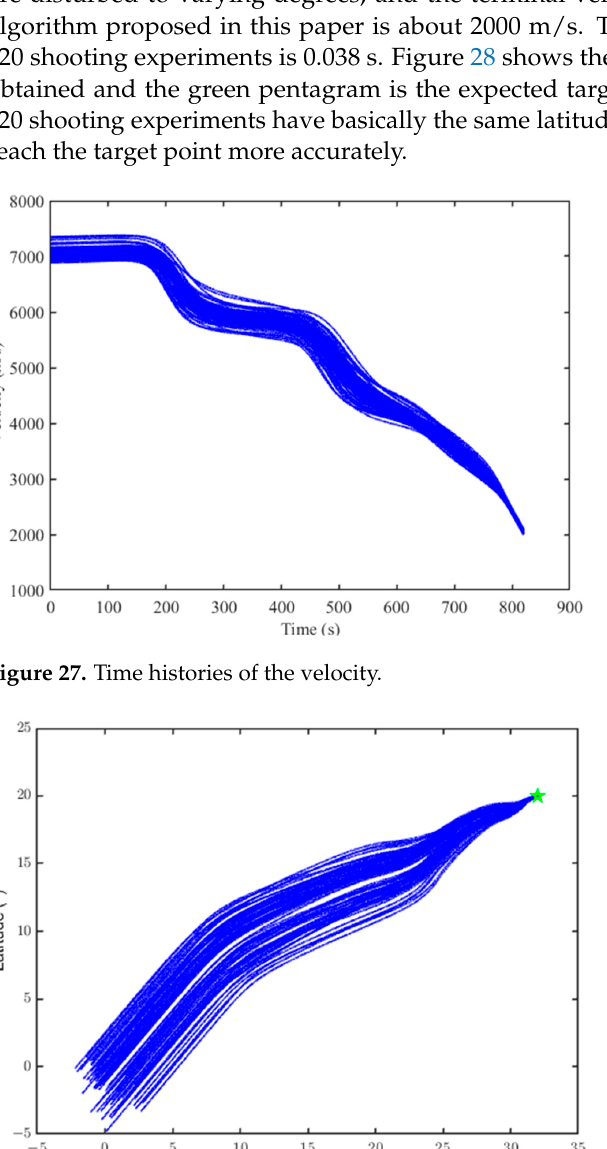
Table 4. Monte Carlo simulation disturbance settings.